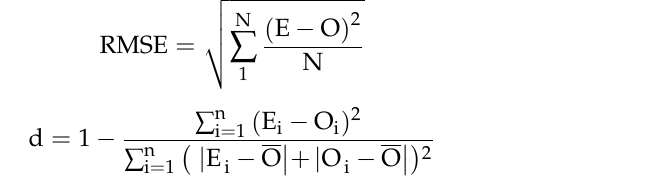
Table 2. Rs (cid:2870)(cid:2872)(cid:2918) : total daily global solar radiation (MJ m − 2 ); R (cid:2924) : total daily radiation balance (MJ m − 2 ); Ta: air temperature at the moment of the satellite passage (°C); RH: relative humidity at the moment of the satellite passage (%); Rs (cid:2919)(cid:2924)(cid:2929)(cid:2930) : instantaneous global radiation at the moment of the satellite pas- sage (W m − 2 ); τ (cid:2929)(cid:2933) : atmospheric transmissivity at the moment of the satellite passage; cosZ: cosine of the solar zenith angle at the moment of the satellite passage.